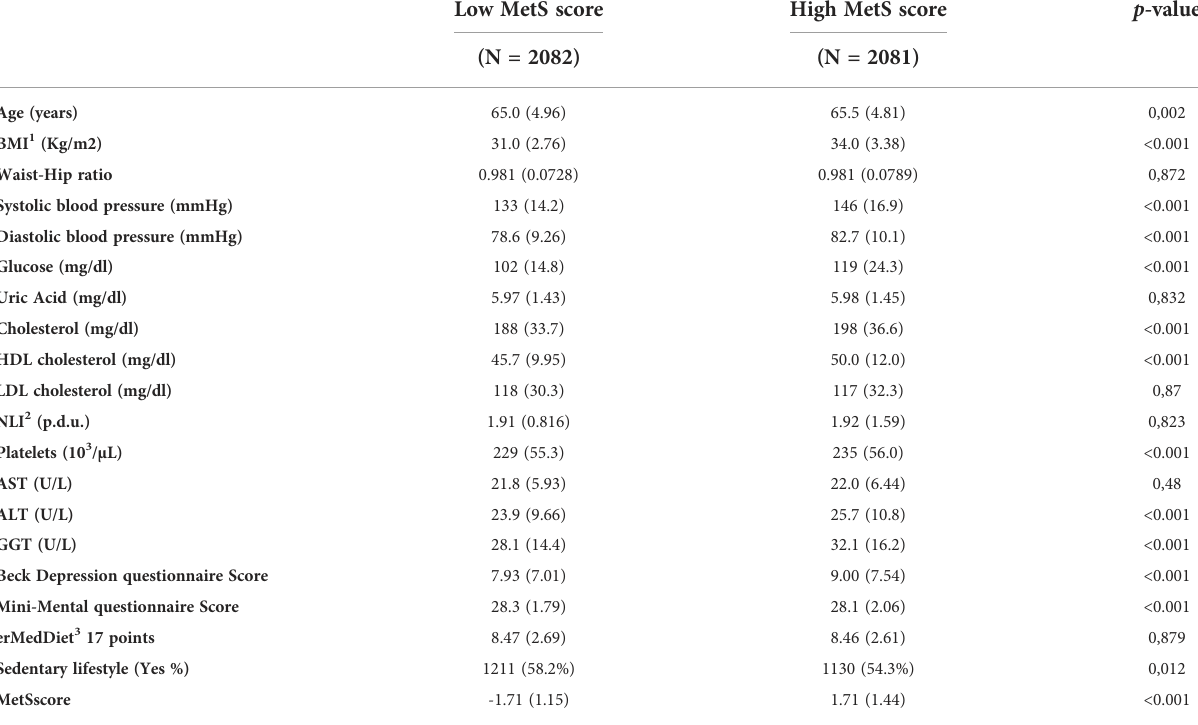
TABLE 1 Baseline characteristics of patients regarding MetS components.